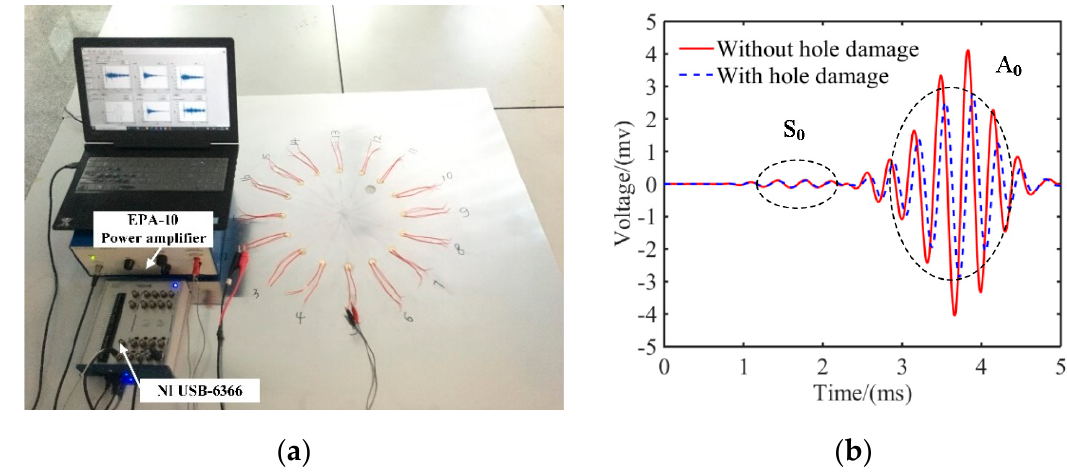
Figure 5. Experimental test setup and the measured signals in one damage path: ( a ) experimental test setup and ( b ) measured signals in the path of A 3 - S 11 .